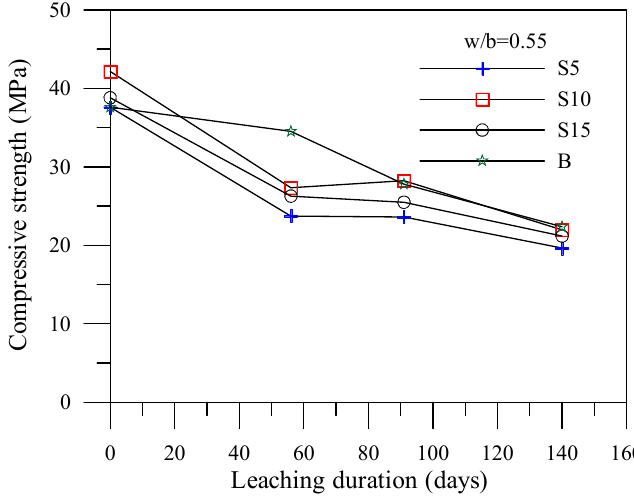
Figure 6. Compressive strength vs. leaching duration for the specimens with silica